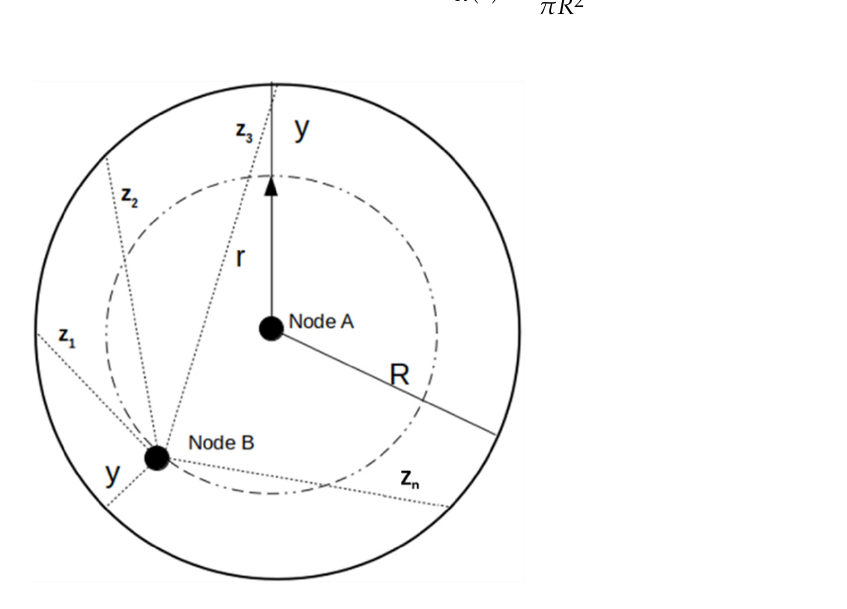
Figure 5. Probability of the distance that neighbor node (B) is far from node (A), and the possible paths that can follow.